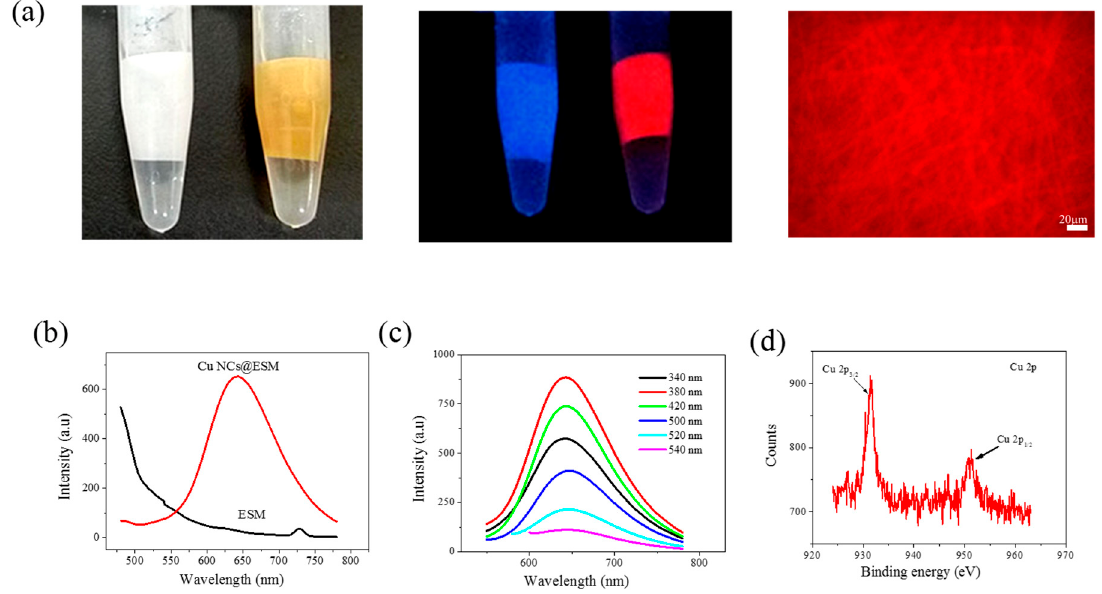
Figure 2. Photos and spectra of Cu NCs@ESM by NH 2 OH · HCl reduction under alkaline condition. ( a ) Photos of Cu NCs@ESM under room light (left) and 365 nm UV light (middle) along with the fluorescence microscopy image (right); ( b ) Fluorescence emission spectra of Cu NCs@ESM and ESM excited by 365 nm; ( c ) Fluorescence spectra of Cu NCs@ESM with varying excitation wavelengths from 300 to 560 nm; ( d ) XPS spectrum of Cu NCs@ESM in the Cu 2p region.